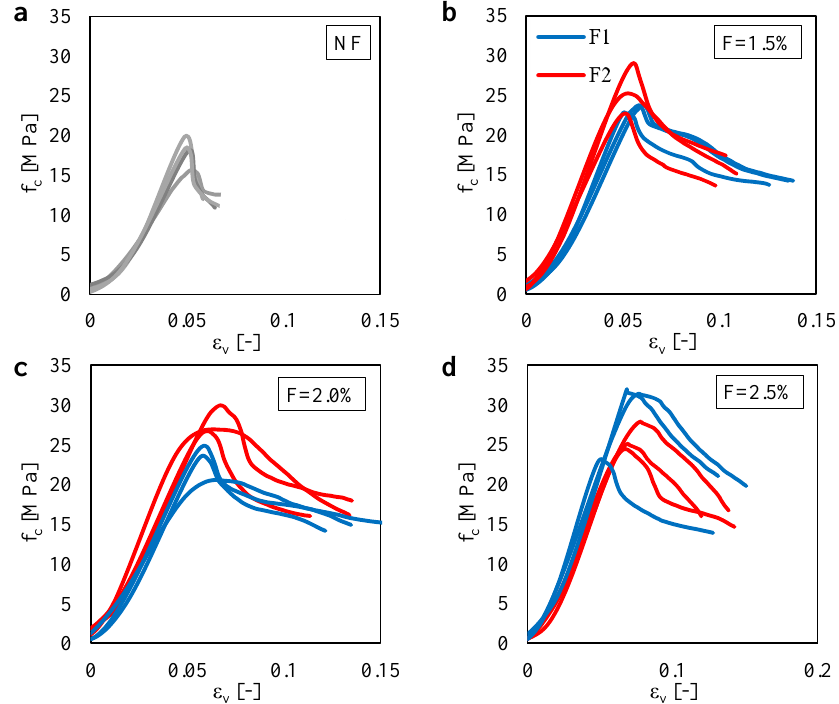
Figure 10. Compressive stress f c related to the vertical deformation ε v measured in the CTs for: ( a ) the unreinforced case (NF). Reinforced cases by assuming two fiber types (F1 and F2) with fiber content equal to ( b ) 1.5%; ( c ) 2.0%, and ( d ) 2.5%.